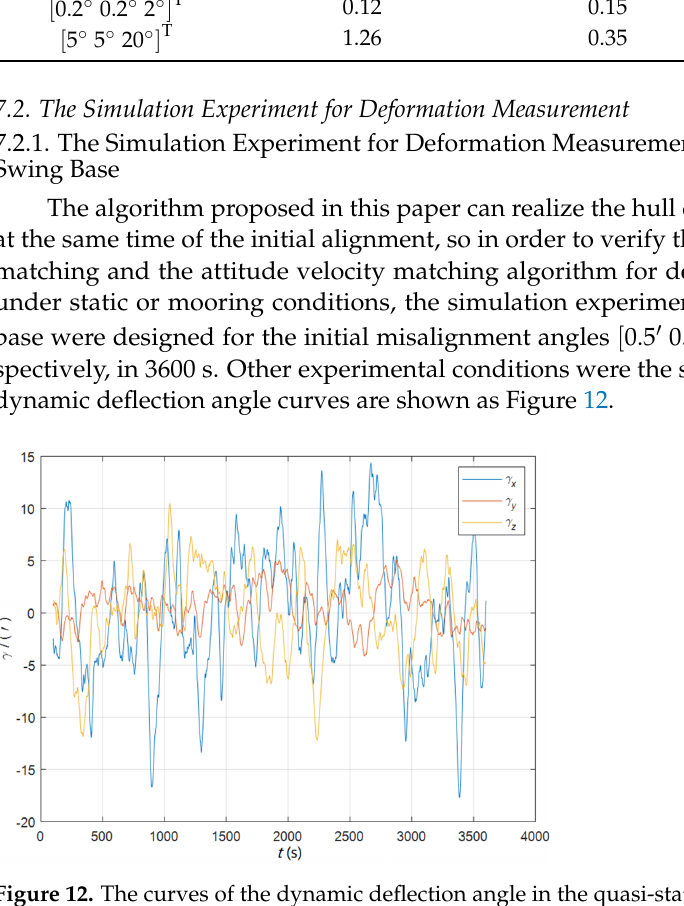
φ Figure 11. The error curves of in the cases of the initial misalignment angles T [5 5 20 ] Table 3. RMSE values of φ in the cases of large and small initial misalignment angles. Initial φ φ Table 3. RMSE values of in the cases of large and small initial misalignment angles. Initial φ